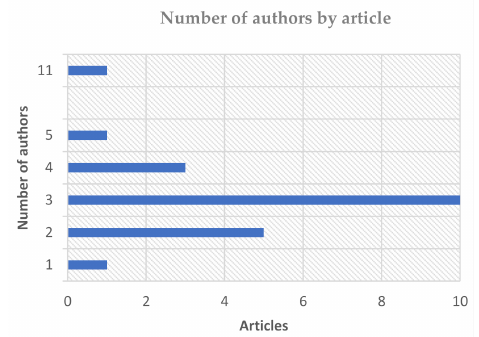
Figure 5. Number of authors by article.